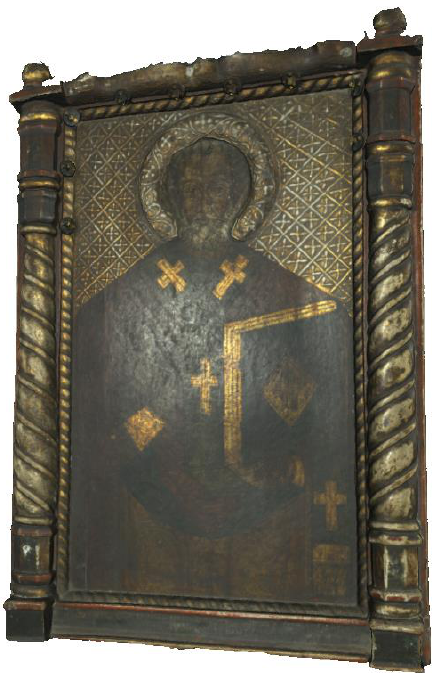
Figure 10. 3D dissemination model of the “Icon of Saint Nicholas of Myra”.